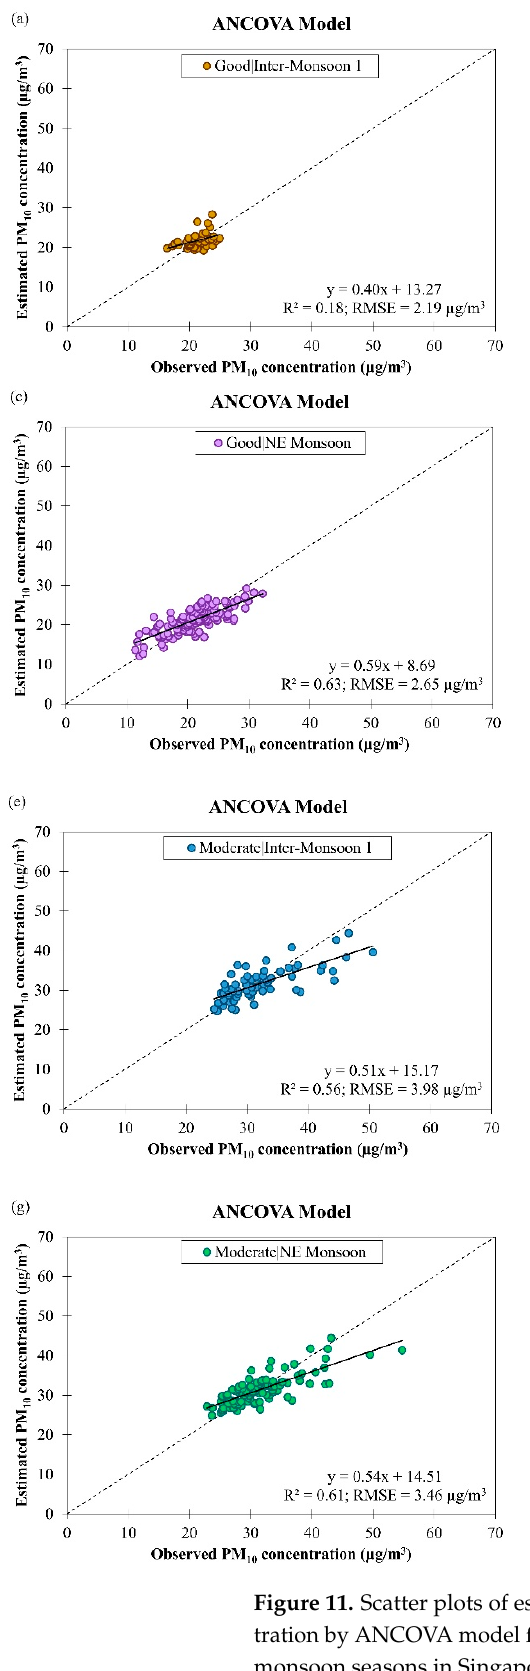
2.86 µg/m 3 and 3.98 µg/m 3 during moderate air quality. The highest RMSE value (3.98 µg/m 3 ) was attained during moderate air quality in inter-monsoon 1 season, and this could be due to large variation in daily PM 10 concentration (as indicated by the outliers in Figure 4b) as a result of the prolonged smoke haze event from the NE monsoon season, which limited the dispersion of PM 10 by the meteorological parameters (for examples, wind speed, wind direction and rainfall) [45]. The ANCOVA model for daily PM 10 con- centration estimation in Singapore showed the best performance during good air quality